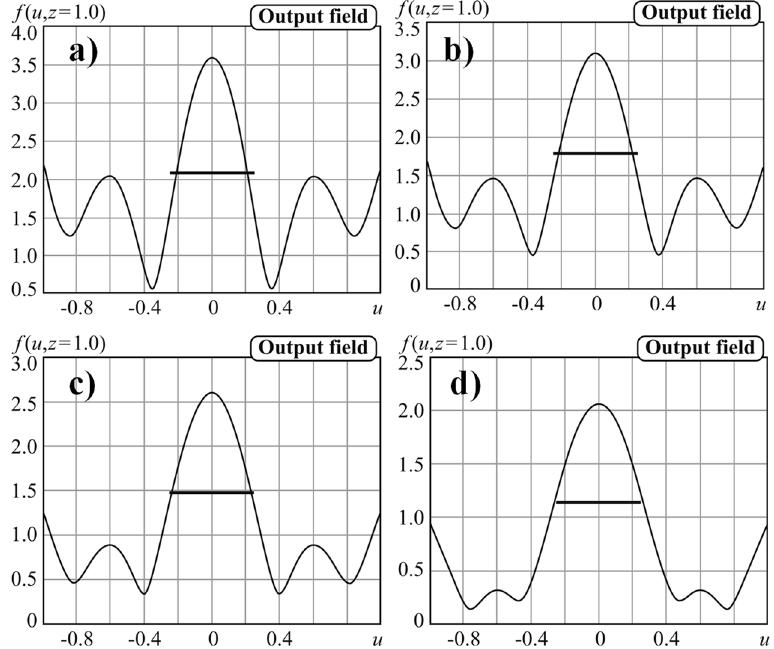
Figure 9. The amplitude of the field of Equation (6) with a = 10 and T = 5 λ propagated at the distance z = λ for different values of the power degree: ( a ) N = 50, ( b ) N = 100, ( c ) N = 200, ( d ) N = 300.